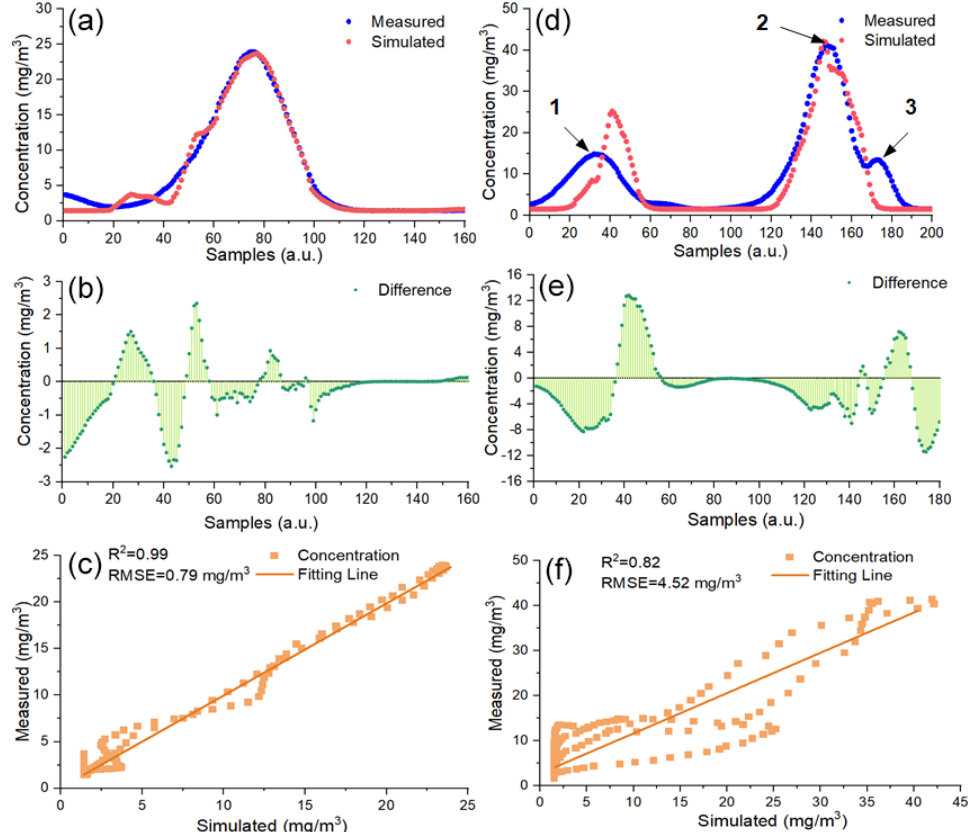
Figure 4. Comparison between the measured samples and the simulated ones based on the parameters in Table 1: (a) Flight 6 and (d) Flight 15. The difference in simulated CH 4 concentration data and actual measured ones: (b) Flight 6 and (e) Flight 15. Correlation analysis: (c) Flight 6 and (f) Flight